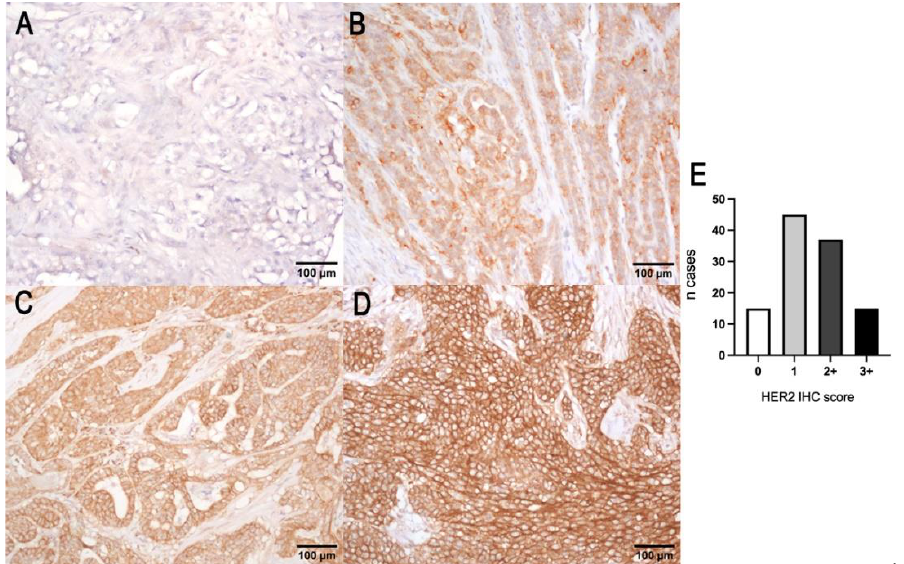
Figure 2. HER2 protein score of canine mammary tumors. ( A ) Negative (0), showing no immuno- reactivity for HER2; ( B ) negative (1+), characterized by a weak incomplete membrane expression of HER2; ( C ) equivocal (2+), showing a complete or basolateral moderate HER2 expression; ( D ) overexpression (3+), characterized by an intense complete membranous labeling; ( E ) histogram representation of the number of cases showing the 4 scores of the IHC of HER2.